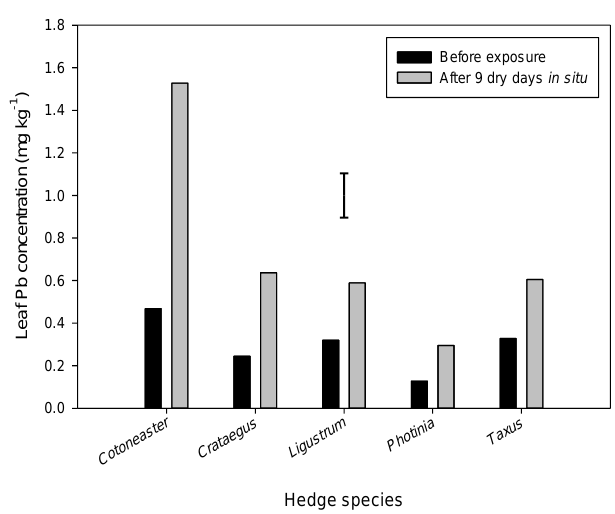
Figure 6. Mean lead (Pb) leaf concentration before and after a 9-day exposure to roadside traffic, in rain-free conditions for the five studied hedge species. Bars are mean of four replicates per species. Vertical error bar represents Least Significant Difference (LSD) of the means (LSD = 0.248). For other measured elements, there were no significant differences in leaf concentrations between the two sampling sites/times (data not shown). There were however species differences in the extent of elements’ accumulation in the leaves. Cotoneaster had highest leaf Cu concentration, 8.15 mg kg −1 , and Photinia ‘Red Robin’ lowest, 1.80 mg kg −1 (LSD = 2.794). Ligustrum , followed by